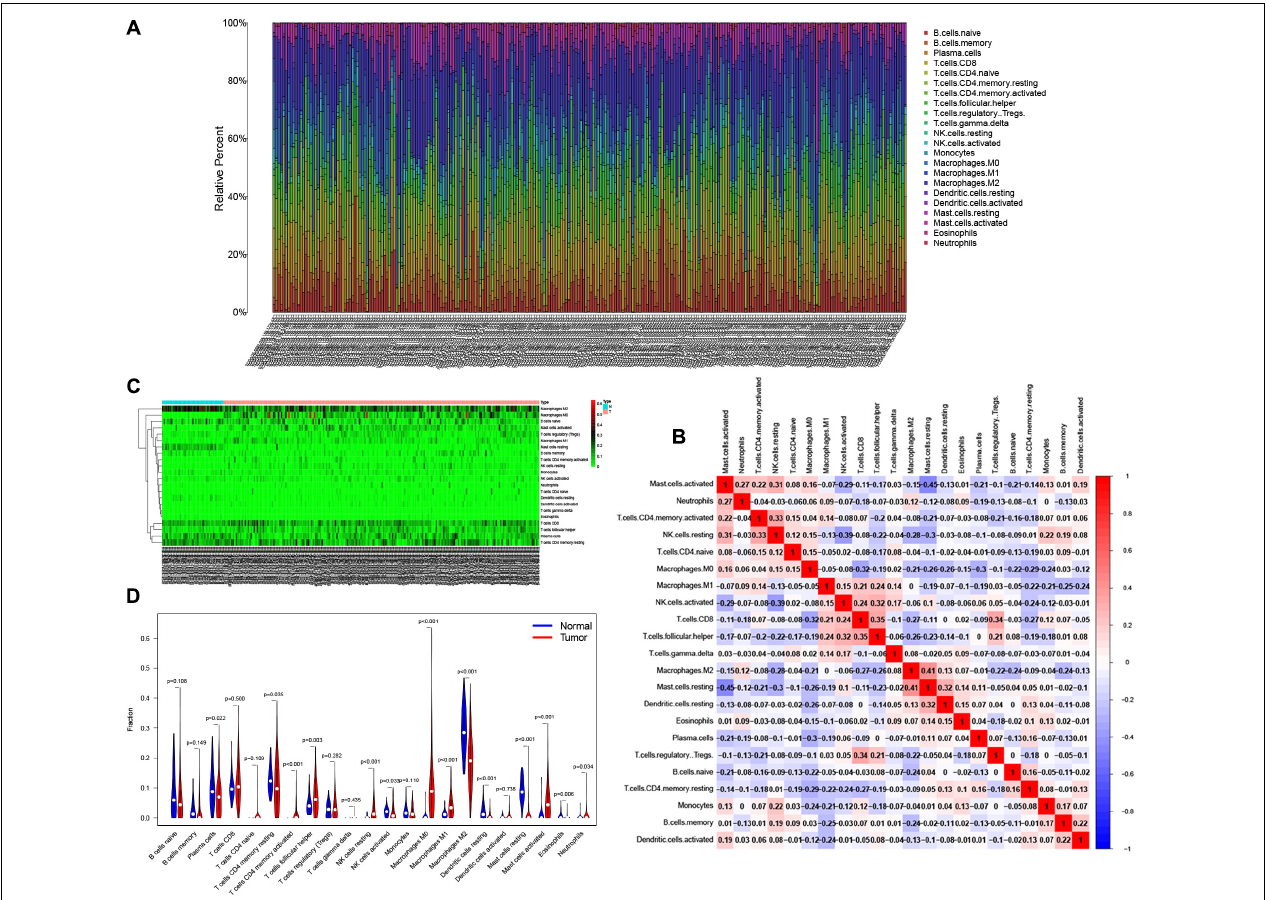
FIGURE 7 | Tumor infiltrating immune cells in the tumor microenvironment (TME).CIBERSORT algorithm was used to calculate level of 22 Tumor infiltrating immune cells in CRC patients (A) . The correlation matrix of 22 types of Tumor infiltrating immune cells in CRC (B) . The “Pheatmap” package was used to visualize the infiltration of immune cells in CRC patients (C) . Difference in the proportion of 22 Tumor infiltrating immune cells between Normal tissue and Tumor tissue (D)